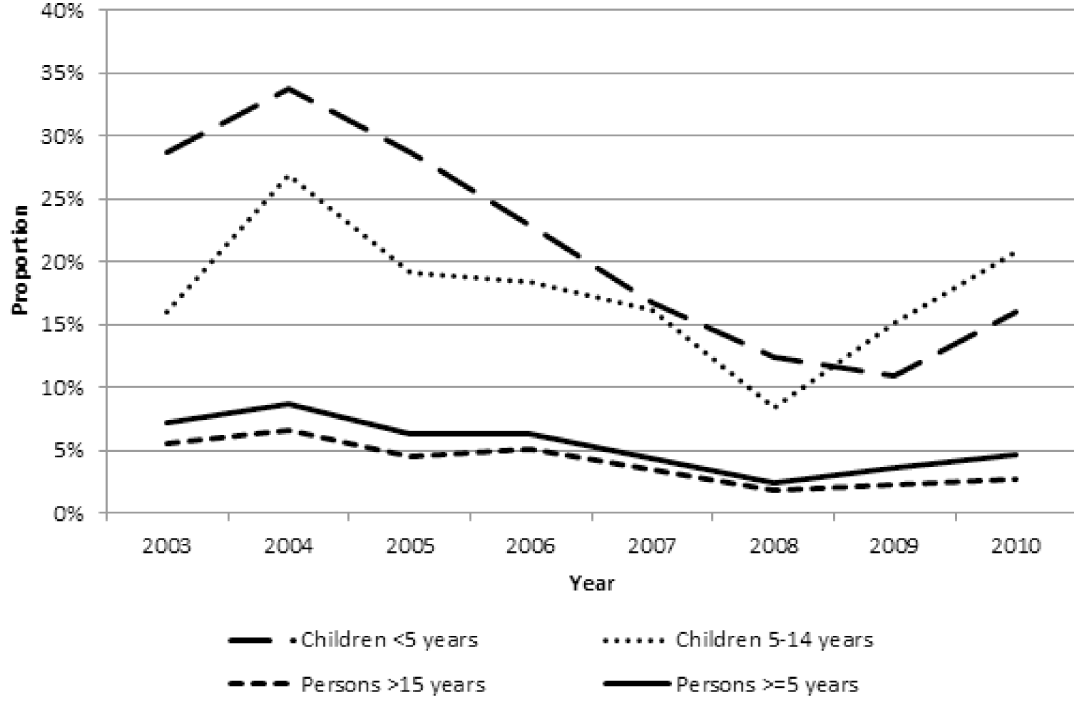
Figure 3. Malaria mortality as a proportion of all-cause mortality by age group.